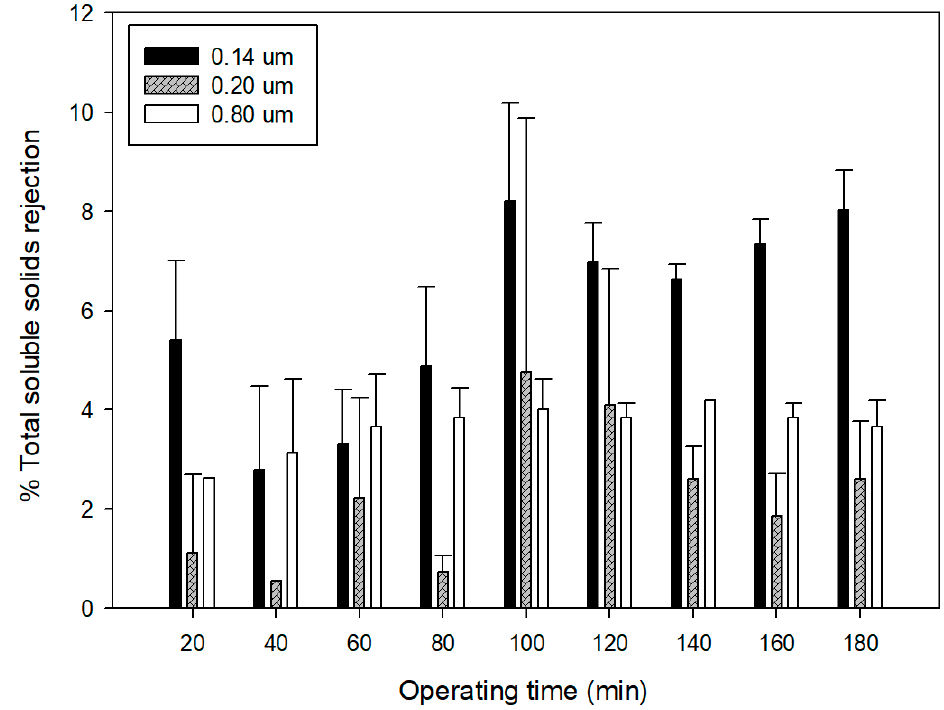
Figure 8. Rejection of MF membranes towards soluble solids content. Table 4. Anthocyanins content in the feed and permeate stream of investigated membranes.